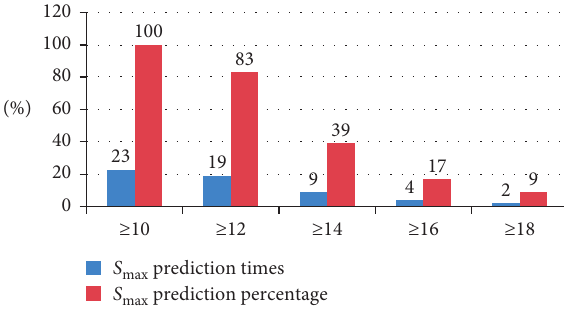
Figure 8: Distribution of S max ( Φ 75mm) during the